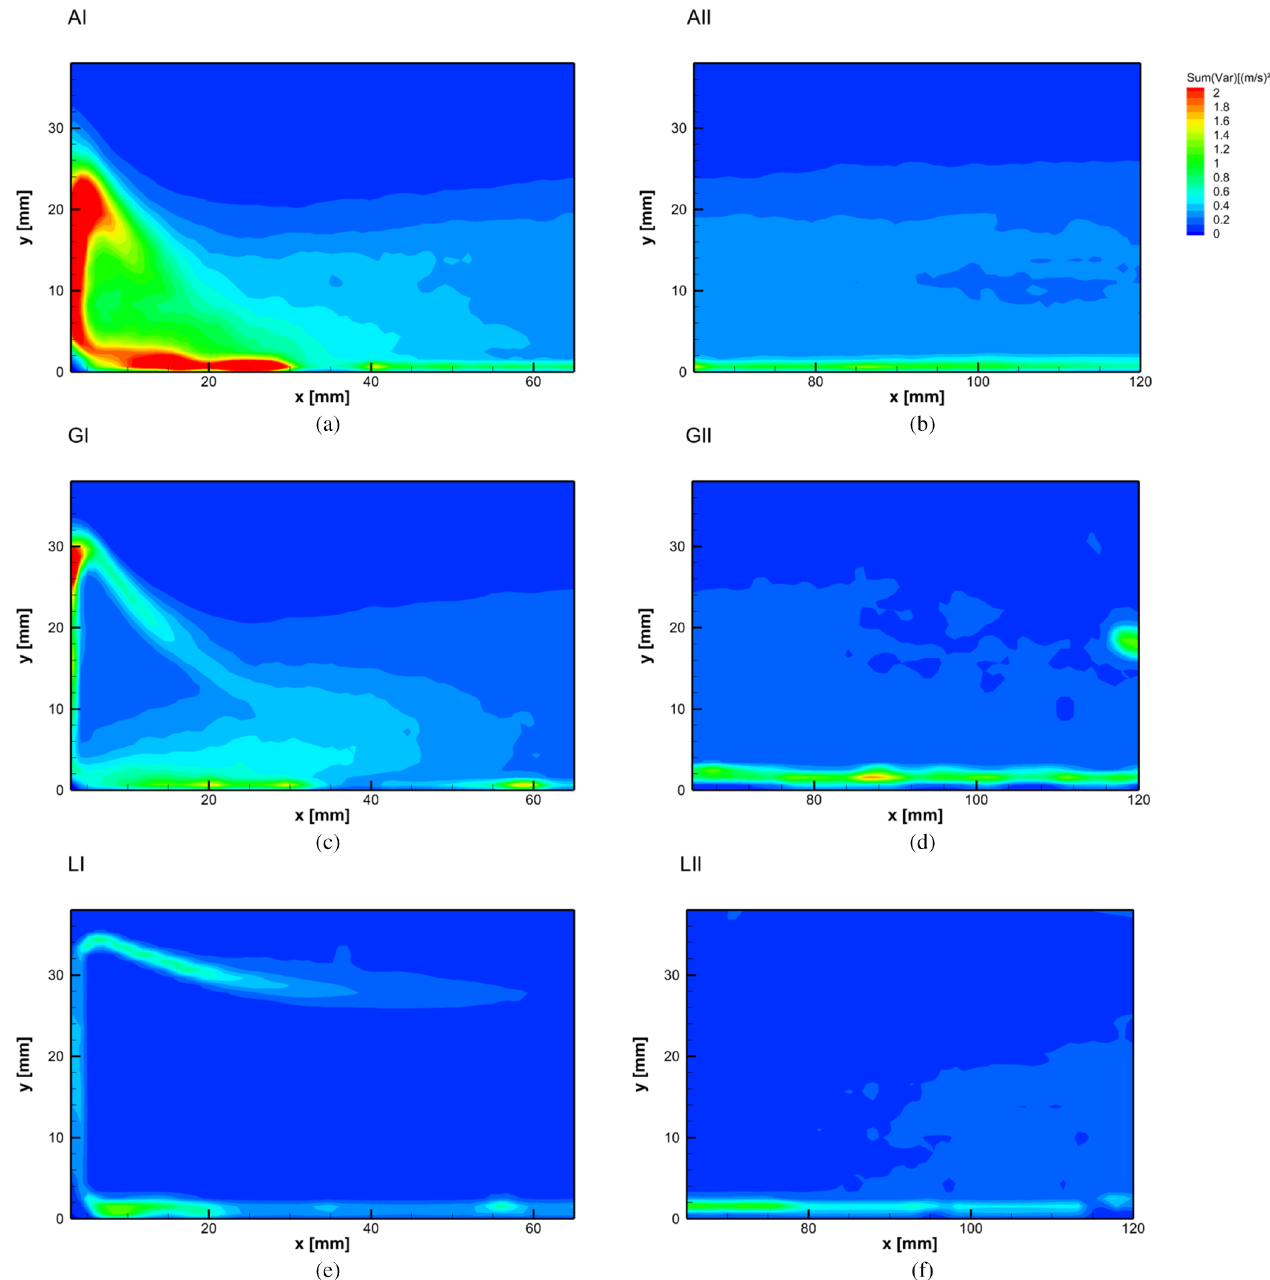
Fig. 8. Velocity components variances sum distributions in the branches A, G and L respectively: (a) AI, (b) AII, (c) GI, (d) GII, (e) LI and (f)